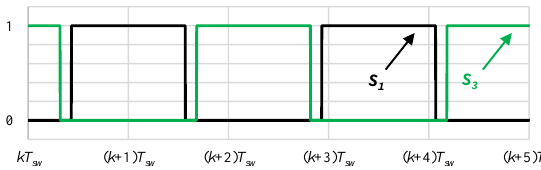
Figure 2. Triggering gate signals of S 1 and S 3 when the SAB operates under duty-cycle modulation.